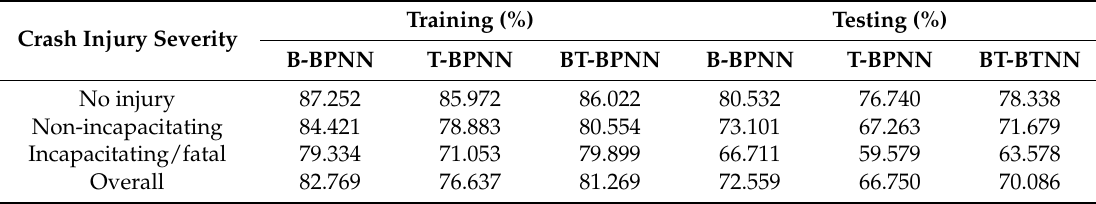
Table 9. Prediction accuracy of BPNN model in the training and